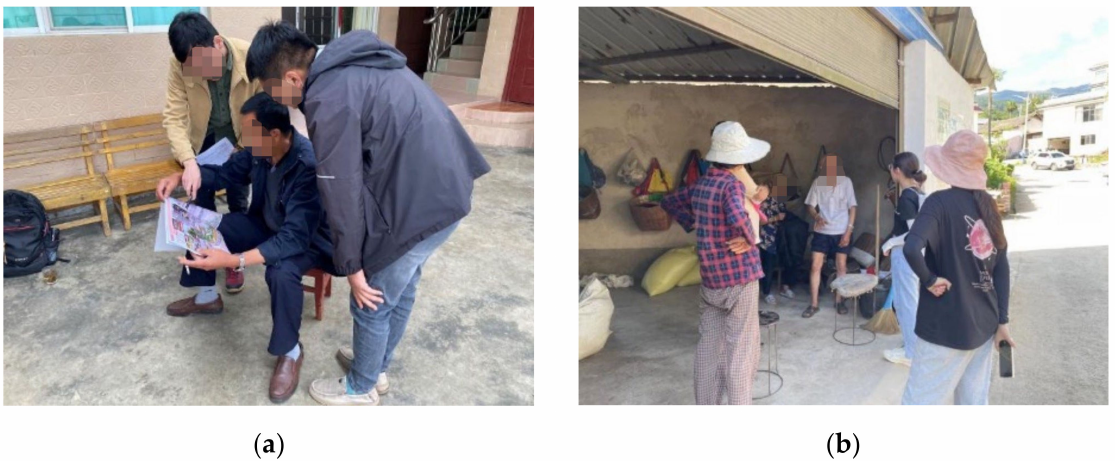
Figure 4. Planners consulting with the local villagers on rebuilding their surrounding environment. ( a ) Villagers sharing their opinions with the planners on the site design; ( b ) Villagers giving sugges- tions on the industrial revitalization. Source: the authors, taken in August